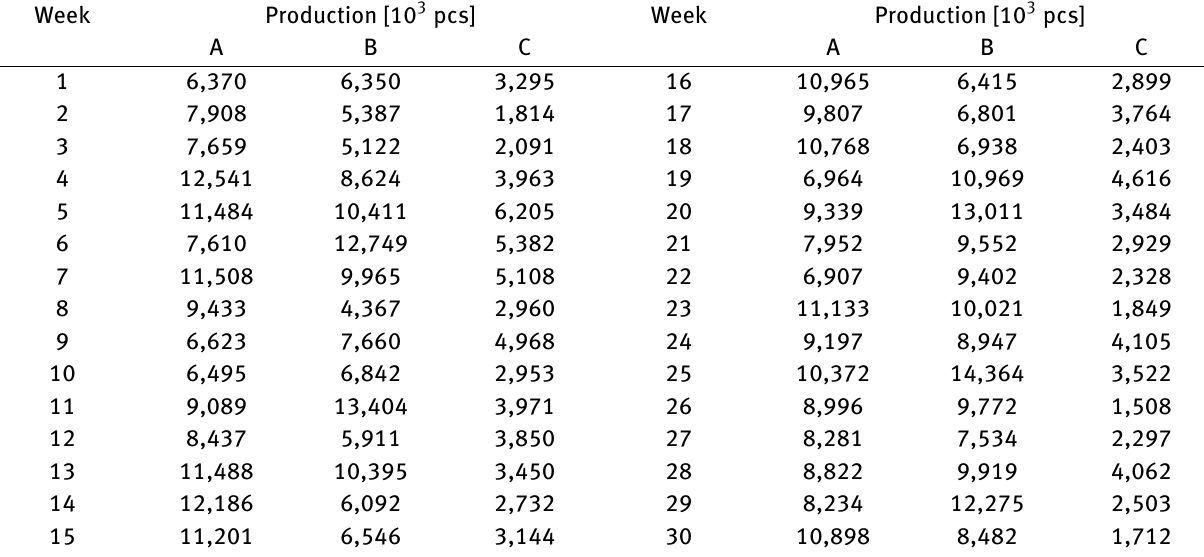
Table 1: Demand for products A, B, C observed for 30 weeks.